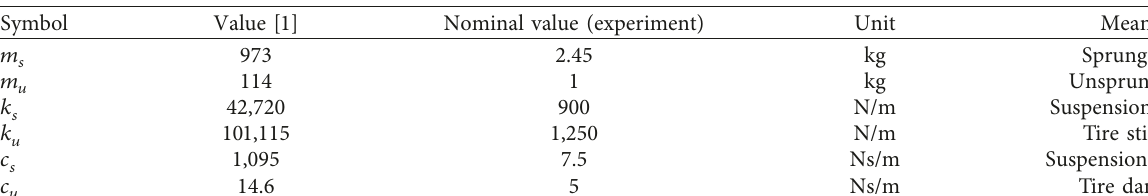
Figure 1: Two DOF suspension model. Table 1: Model